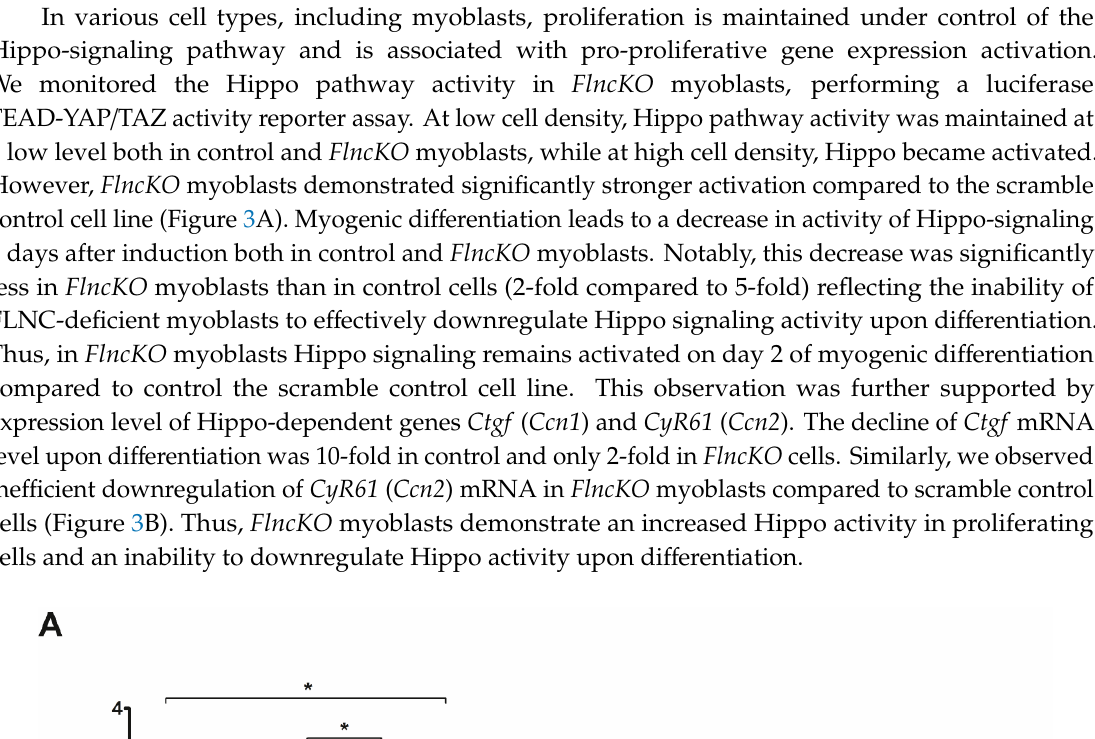
Figure 3. Loss of FLNC affects TEAD-YAP/TAZ activity in myoblasts during differentiation. (A) HOP-flash luciferase assay was performed in both under proliferating condition and during differentiation. In low density conditions no differences of TEAD-YAP/TAZ activity were obtained, whereas in high density FlncKO cells exhibit significantly greater increase of TEAD-YAP/TAZ activation. 48 h after changing of the growth media to differentiation media in both FlncKO and scramble cell line we observed significant decrease of TEAD-YAP/TAZ activity. ( B ) Expression of downstream YAP/TAZ-targeted genes were evaluated using qPCR. In scramble cell line mRNA expression of Ctgf and Cyr61 become reduced 48 h after myogenic differentiation induction, when